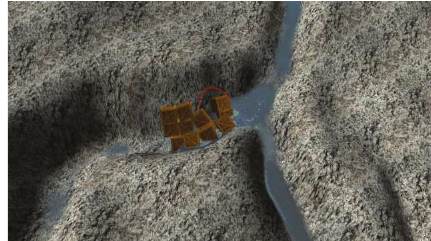
Figure 14: Combining our approach with the method of [11], block- ing bodies can be used to interactively alter where floating bodies end up with the